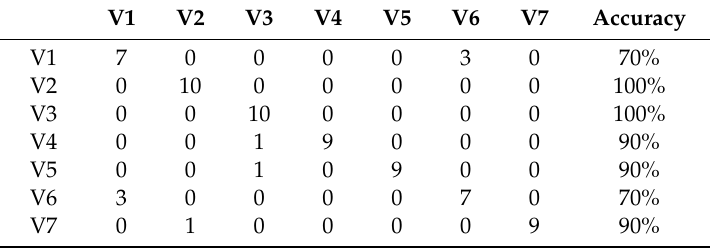
Table 9. Confusion matrix for sweet corn seed classification based on the SDA + SVM